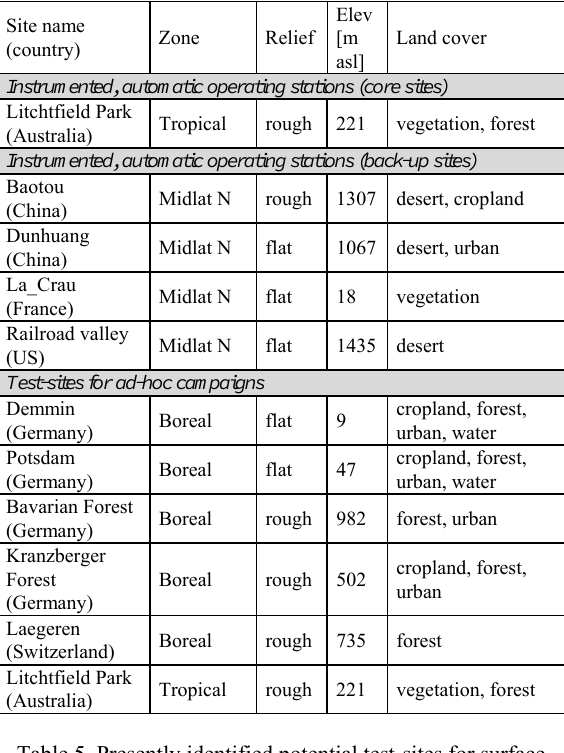
Table 5. Presently identified potential test-sites for surface reflectance measurements.